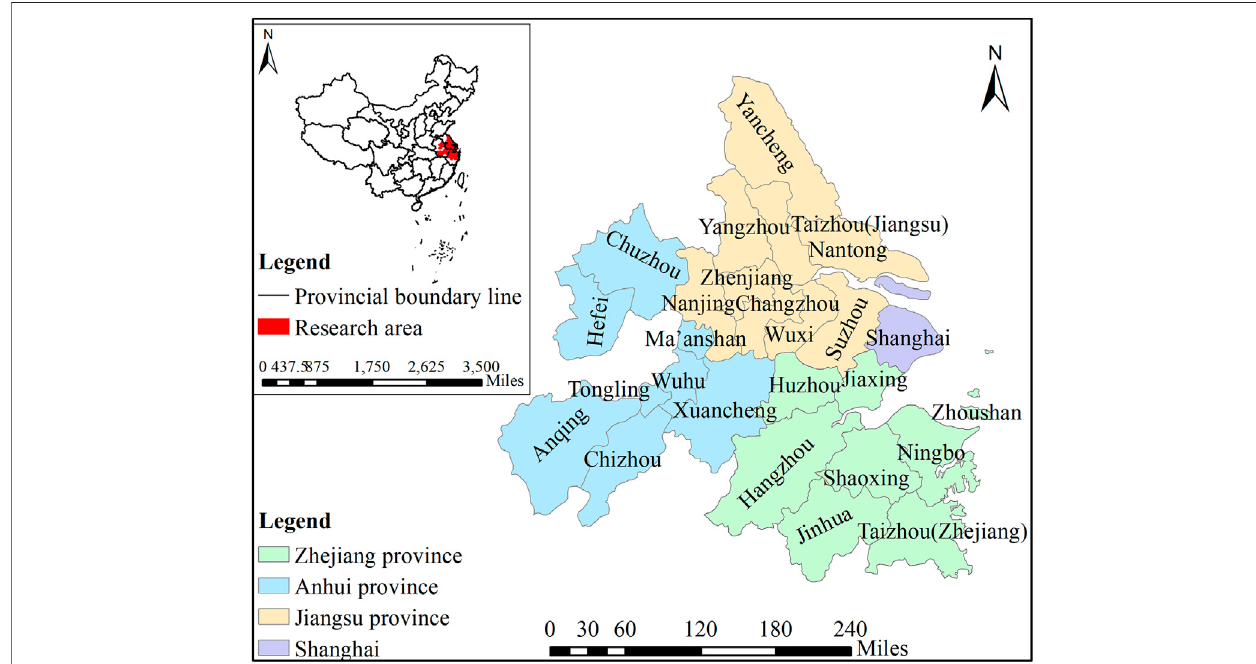
FIGURE 1 | The location map of the YRDUA area.